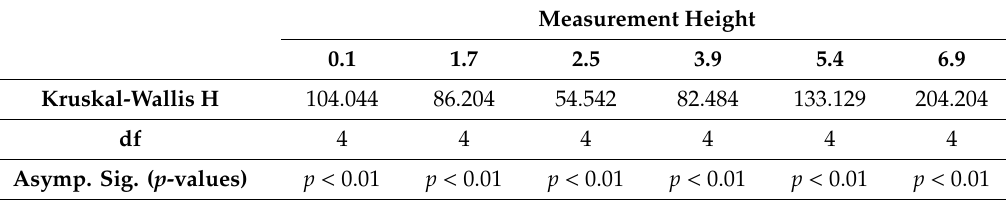
Table 3. Kruskal-Wallis test statistics for stratification